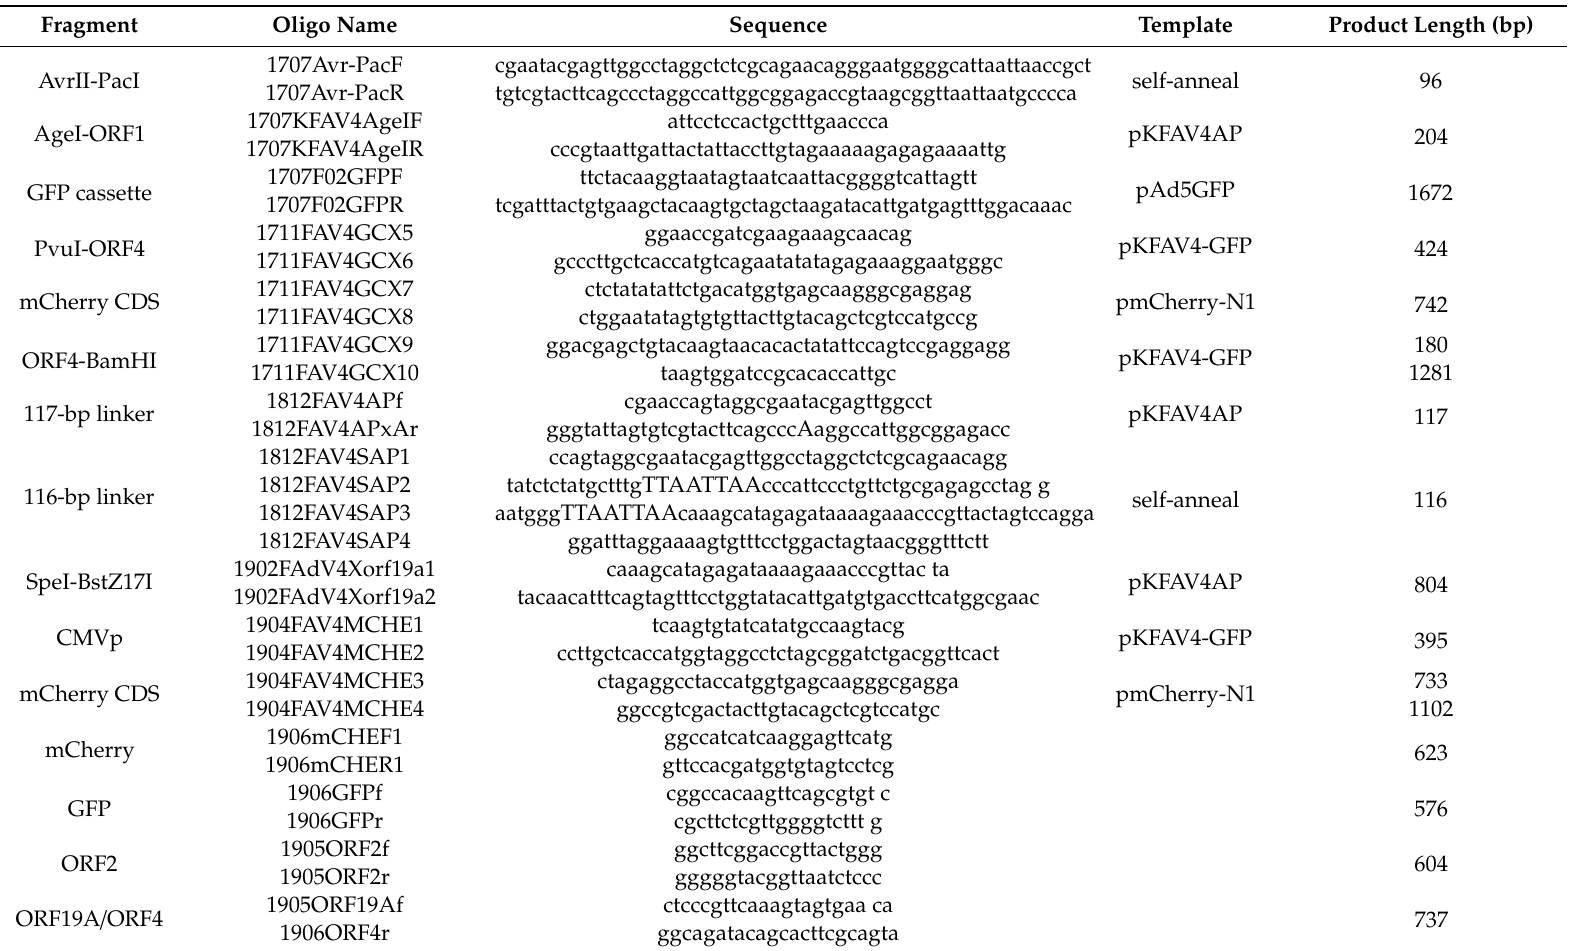
Table 1. Summary information of